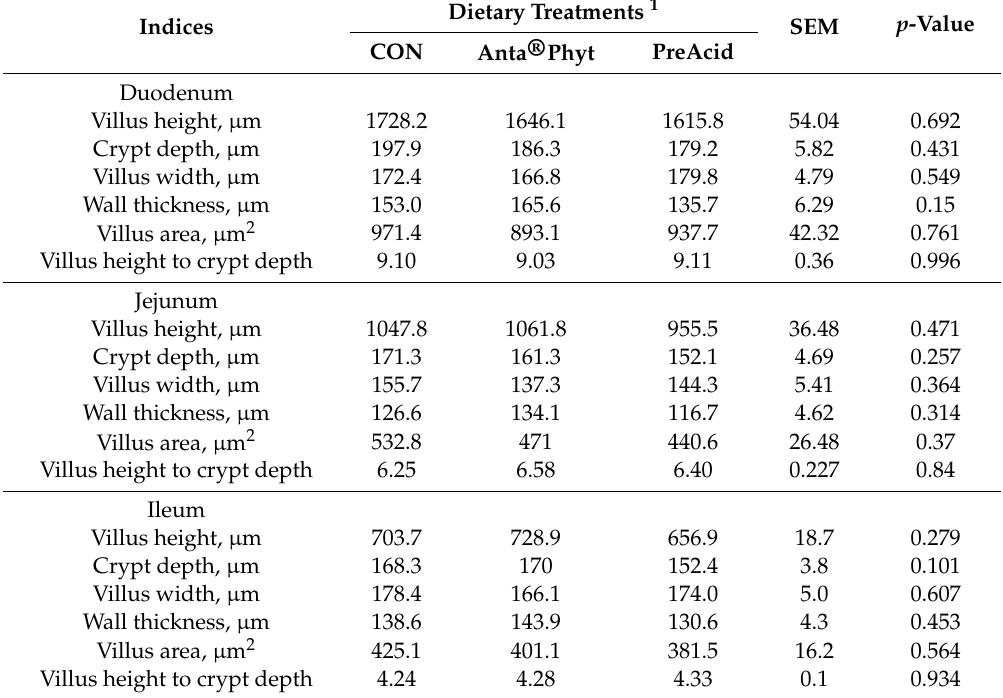
Table 2. E ff ect of dietary treatments on morphological indices of the duodenal, jejunal, and ileal mucosa in 28-d-old